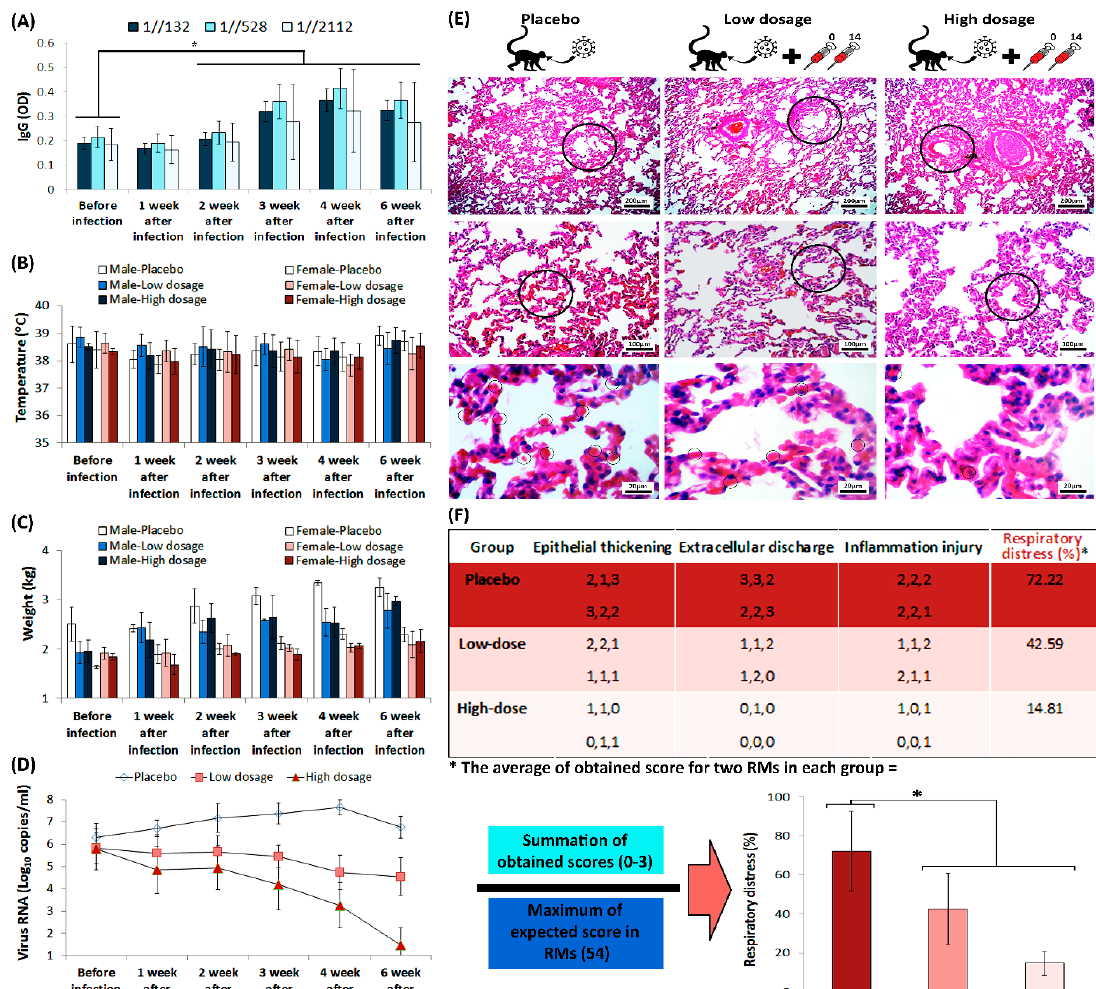
Figure 6. The humoral immunity of RMs during challenge assay. ( A ) IgG titration during challenge assay. The star above the bars represents the significant difference, compared to the control state (before injection) and the 1//132, 1//528, and 1//2112 represent sera dilutions. The “y axis” represents optical density of IgG at 450 nm. ( B ) Monitoring of both male and female RMs’ body temperature, and ( C ) weight, during challenge assay. ( D ) Viral loads in RMs, acquired from throat and anal swabs, were measured by real-time PCR. ( E ) RMs’ lung H&E staining, prepared from placebo and challenge group animals after euthanasia, seven weeks after infection. The circles in the top, middle and low rows represent bronchiole, alveoli and red blood cell, respectively. ( F ) Scoring of the histopathological images is represented as a matter of respiratory distress percentage (%). The star above bars represents significant difference between series ( p -values of less than 0.05 were set as a cut-off for statistical significance).